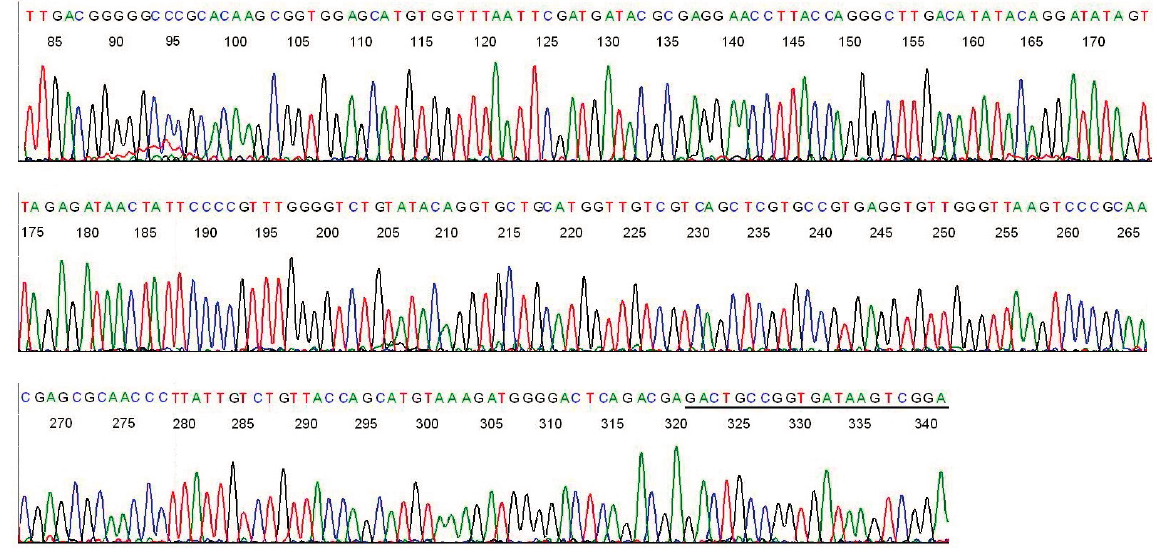
Figure 4. Base-calling sequencing electropherogram of an M1/M2 PCR amplicon showing part of a 358-bp segment of the 16S rDNA of B. miyamotoi in an Ixodes scapularis